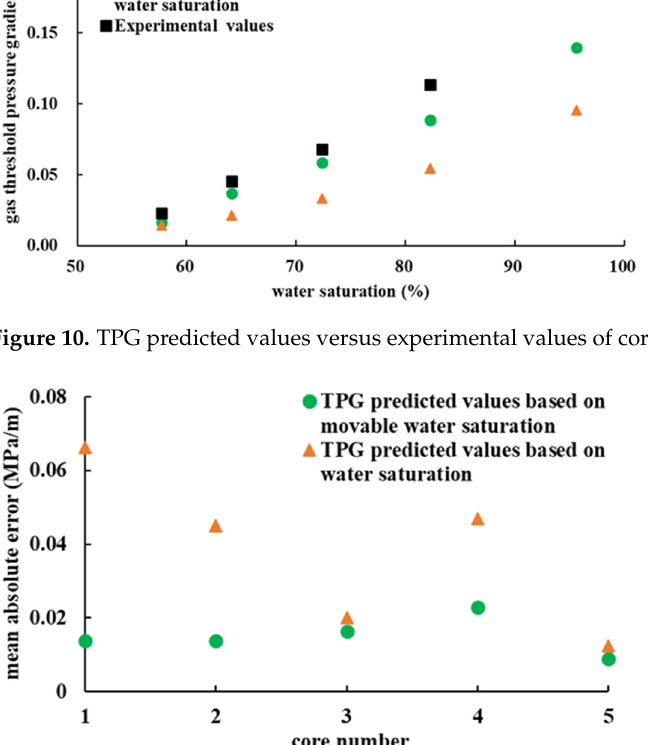
Figure 10. TPG predicted values versus experimental values of core plug D-4.